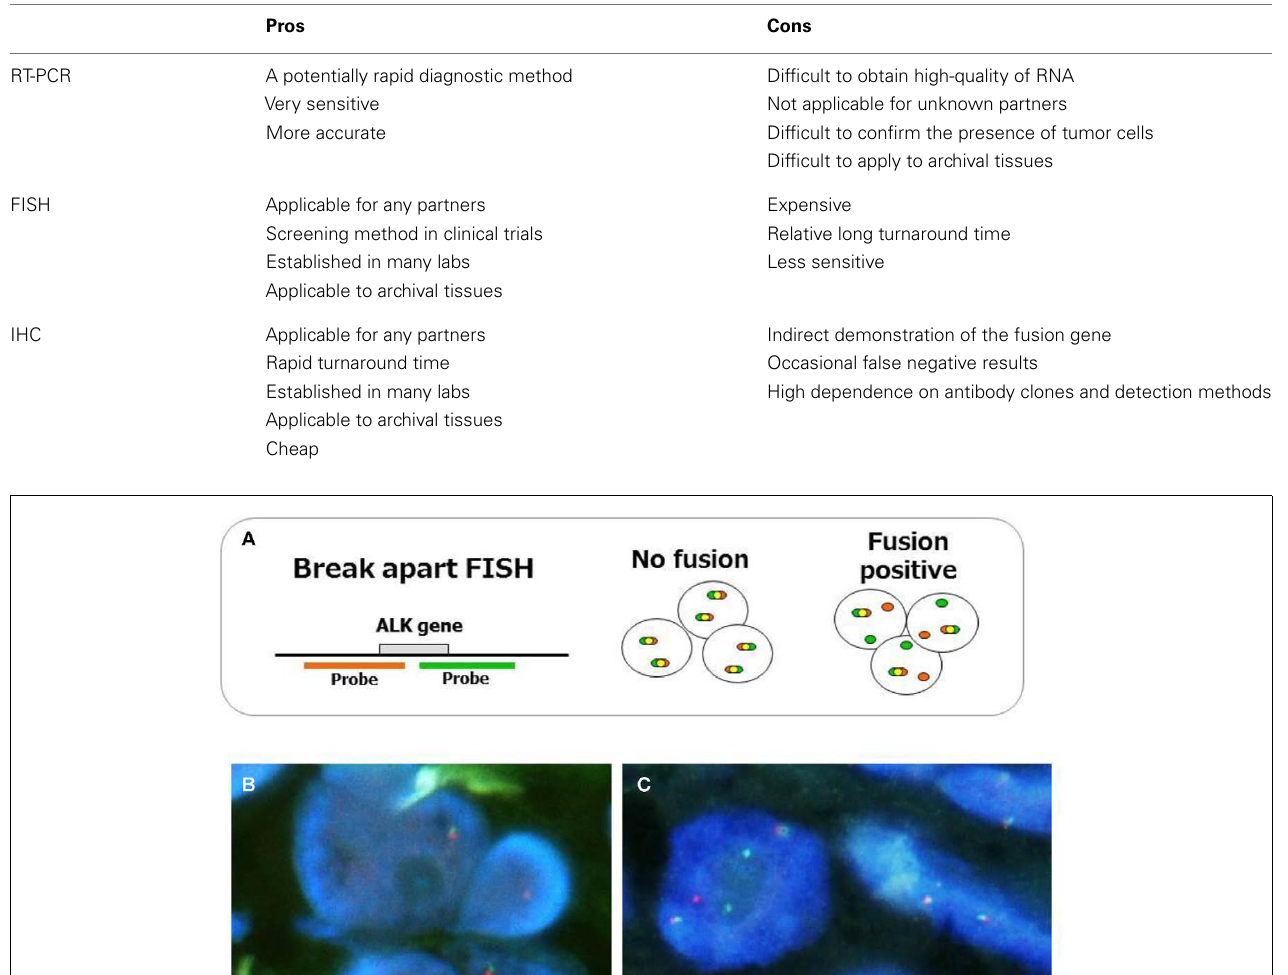
Table 3 |Advantages and disadvantages ofALK detection methods.